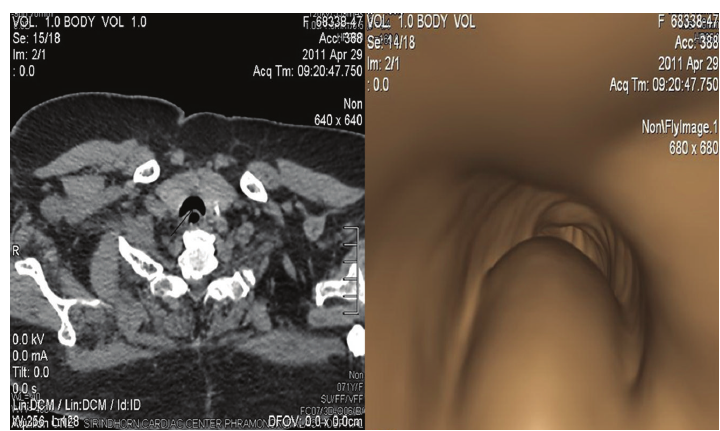
Figure 1: Chest dynamic multislice CT scan and CT virtual bronchoscopy showing collapse of trachea at posterior wall.